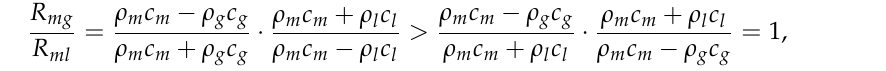
Figure 5. Determination of two critical positions of the energy circle and calibration of liquid level.